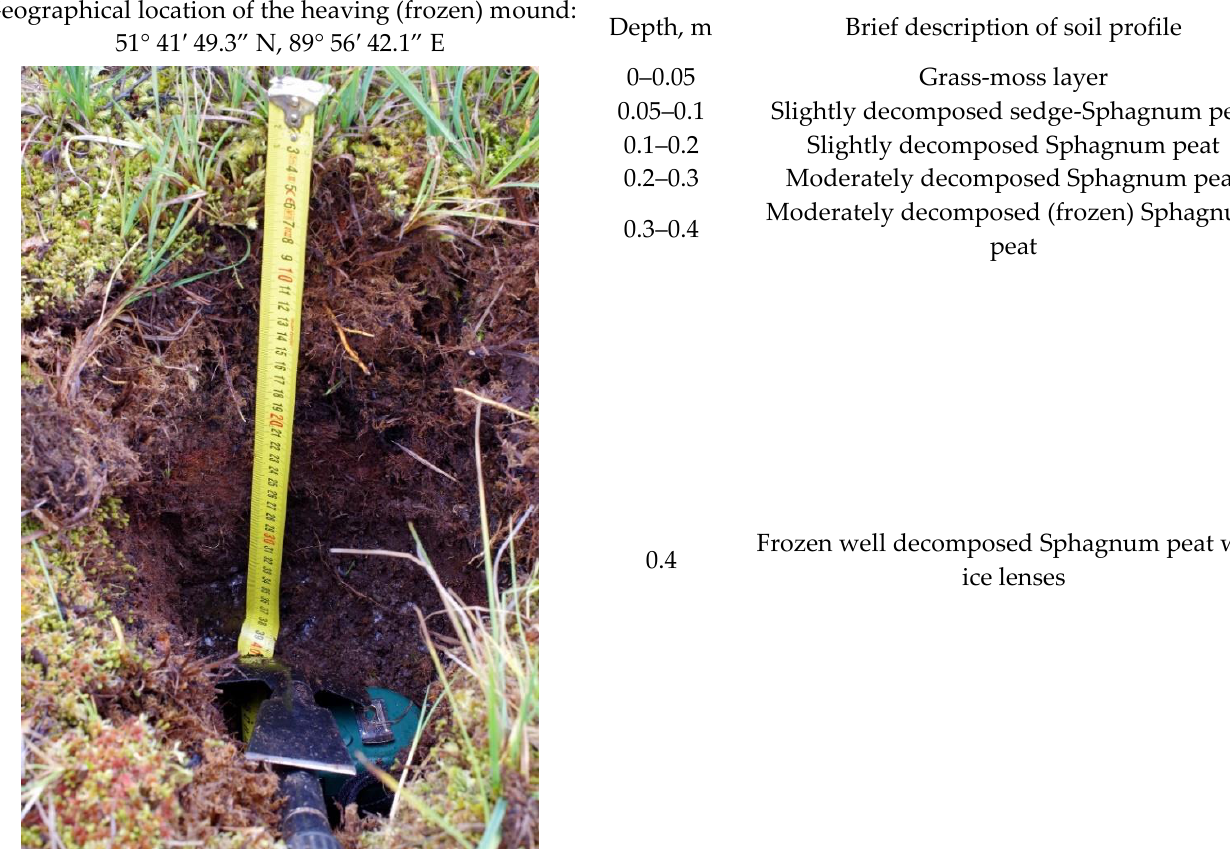
Figure 11. The features of soil profile (section) at the heaving (frozen) peat mound in the Adyr-Khem river valley (Volkova, 2021).